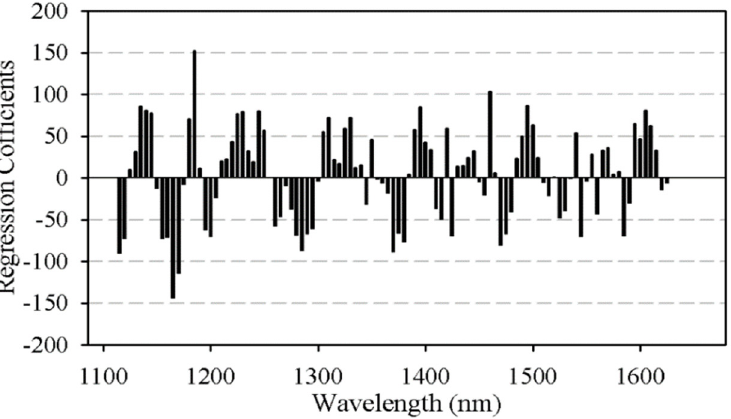
Figure 5. Plotted the regression coefficient of the optimal calibration in single maize amylose content